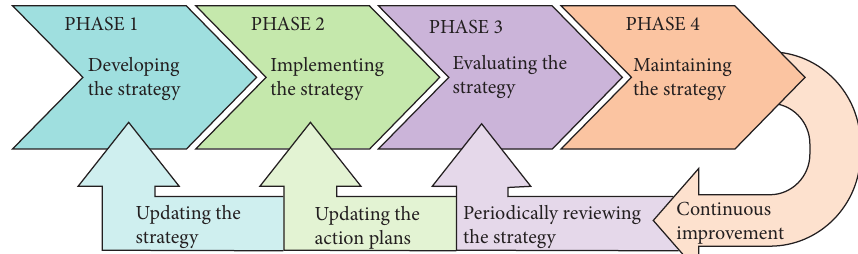
Figure 7: ENISA NCSS lifecycle